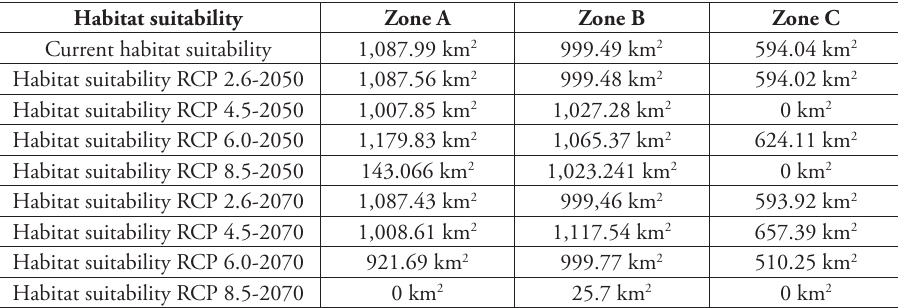
Table 1. Habitat suitability for distribution of G. flavomarginatus considering the different climatic sce- narios